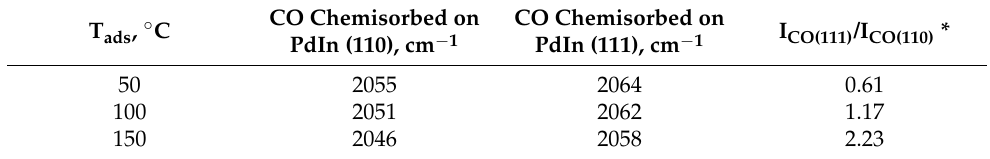
Figure 3. Surface geometry of PdIn(110) ( a ) and PdIn(111) ( b ); ( c ) CO linearly adsorbed on PdIn(110); ( d ) bridge-bonded CO on PdIn(110); ( e ) CO linearly adsorbed on PdIn(111). Pd atoms are blue and In atoms are brown. Table 1. Dependences of CO bands positions and their relative intensities on adsorption temperature.